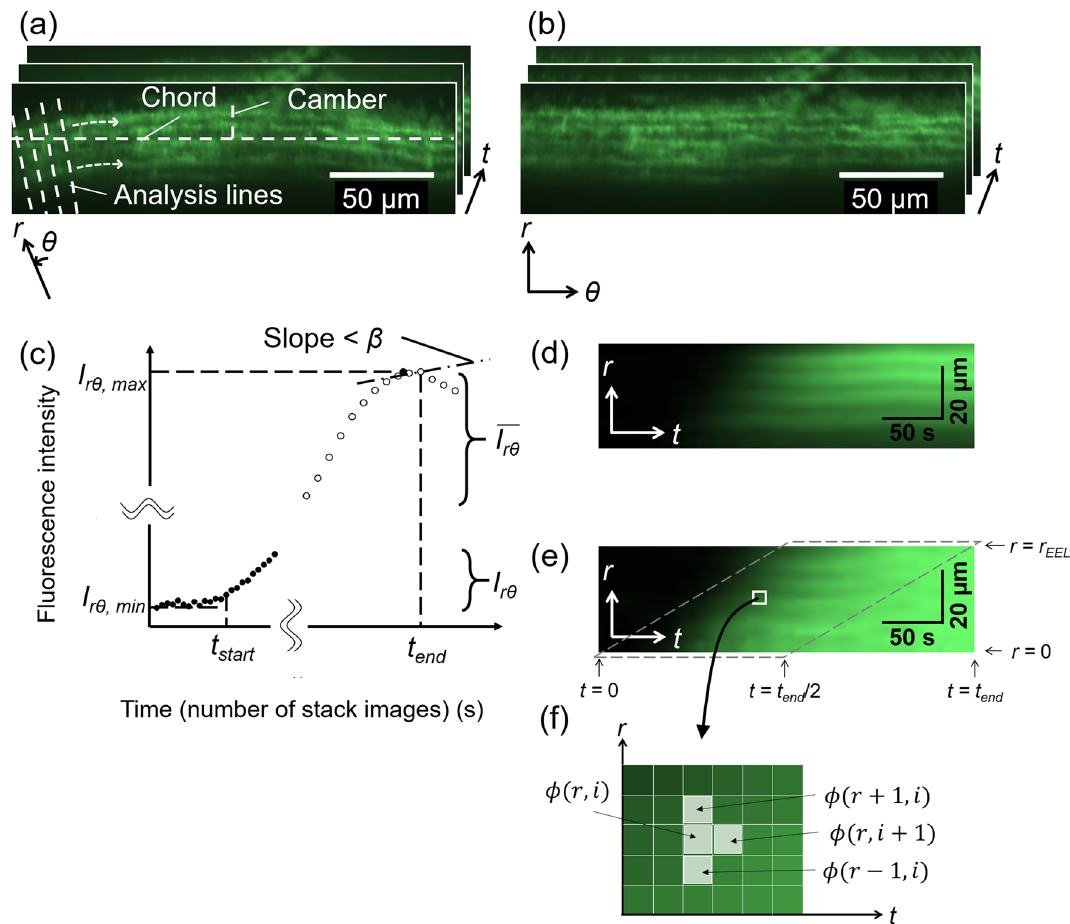
Figure 2. Schematic of image analysis. ( a ) An image stack of fluorescent dye captured in the radial- circumferential ( r – θ ) plane. ( b ) To convert the image of the aortic wall on an arch to images of a flattened one, the chord and camber lengths were measured from any arbitrary EL (outermost layer in this figure) and the center coordinates of the arc were determined. An analysis line was drawn from the center coordinates to an arbitrary position on the left edge of the images and rotated clockwise around the center coordinates. The fluorescence intensity on each line was recorded, and the image stack was reproduced from the intensity data. ( c ) Identification of start time t start and end time t end . The average fluorescence intensity I r θ ( t ) in the aortic region of each slice was measured (closed circles), and the minimum I r θ , min and maximum I r θ , max were measured. t start was defined as the time t when I r θ ( t ) slightly exceeded I r θ , min (see main text for precise definition). The moving average of the fluorescence intensity I r θ ( t ) (open circles) was calculated, and t end was defined as the time t when (cid:31) I r θ ( t ) − I r θ ( t − 1 ) (cid:30) first became less than β . ( d ) A kymograph obtained by reslicing image ( b ) and averaging it on the θ -axis. ( e ) A normalized kymograph with 0 at t start and 1 at t end . Normalization was performed at each r -coordinate. Further image analysis was performed in the region bordered by the broken line. ( f ) Magnified view of the kymograph. The differential of the intensity was calculated for each pixel. These images were taken at 80 mmHg. The graph was created using the Microsoft Excel for Microsoft 365 MSO (16.0.14326.20782). The image was created using ImageJ